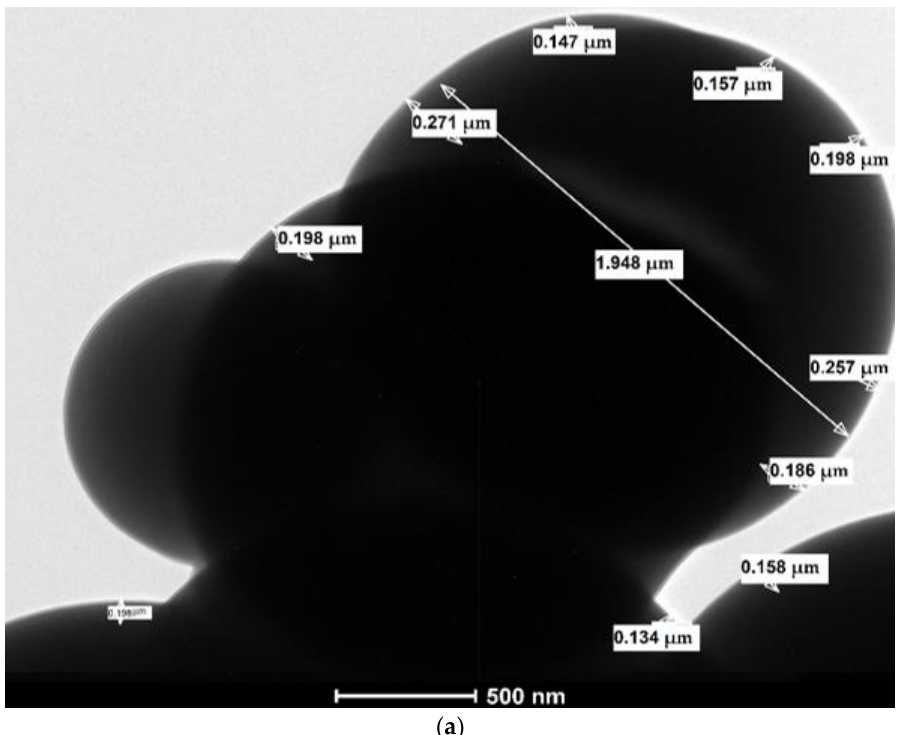
Figure 8. Trial-3 microcapsule TEM images at scales of ( a ) 500 nm and ( b ) 1µm.